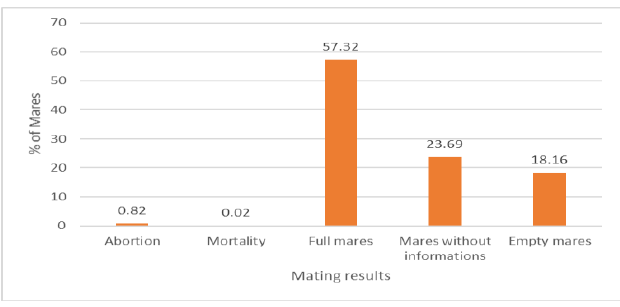
Figure 3. Mating results.